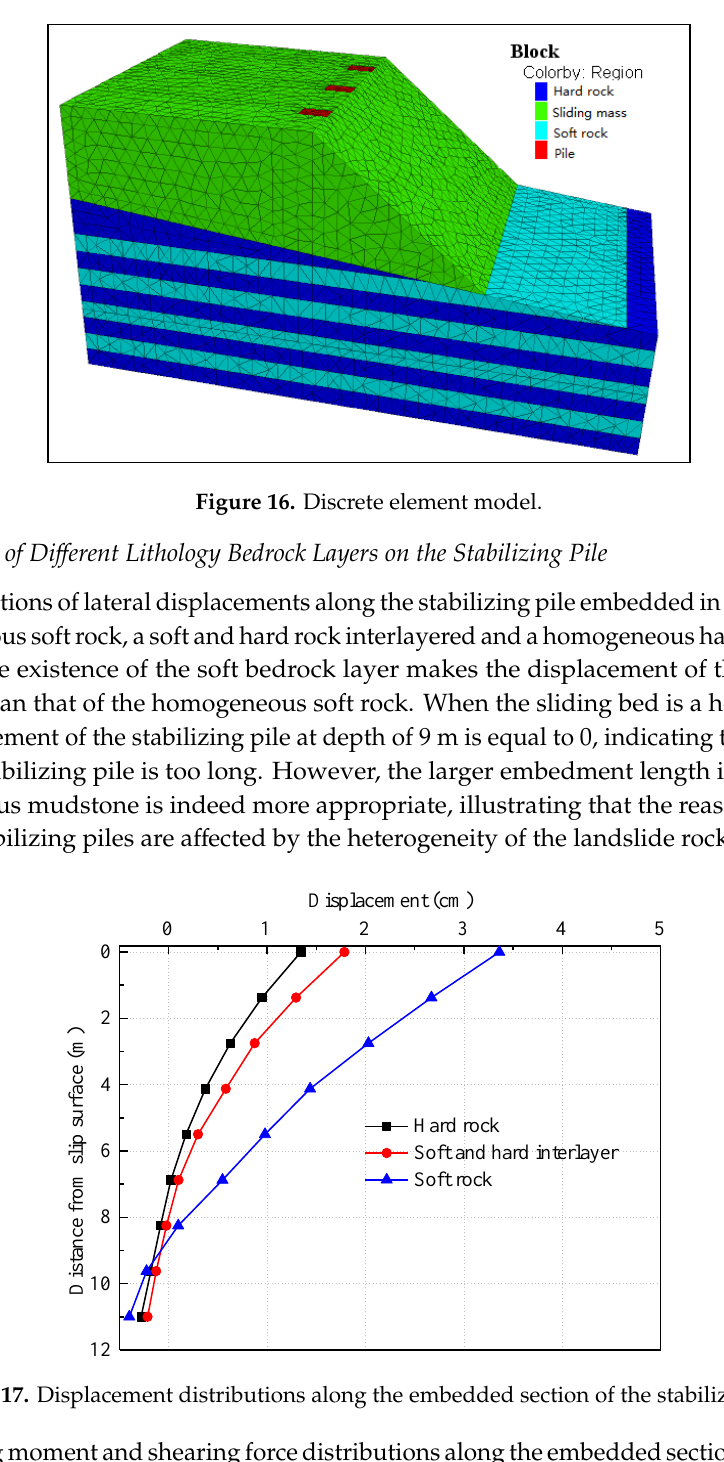
Figure 18. Bending moment distributions along the embedded section of the stabilizing pile. 1086420-2500 -2000 -1500 -1000 -500